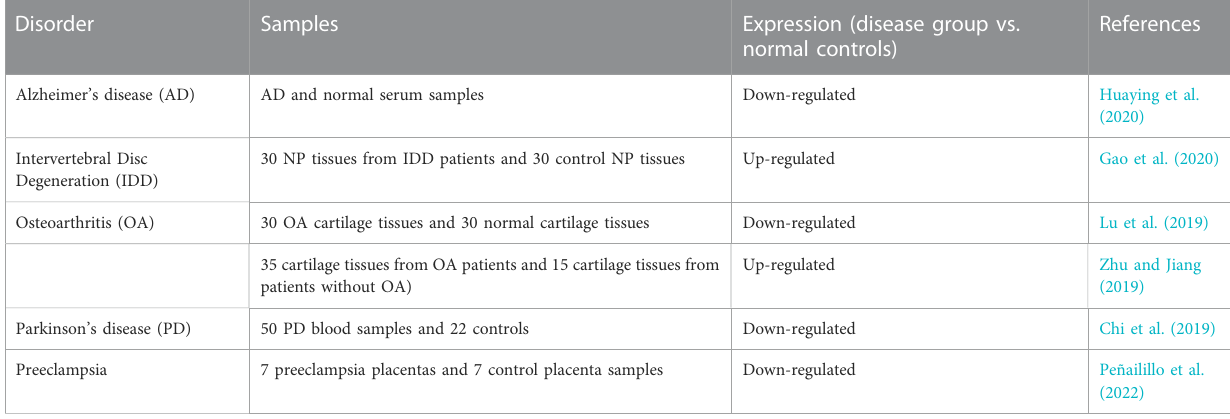
TABLE 10 Studies on humans samples to ascertain how PART1 is expressed in non-cancerous disorders (NP: nucleus pulposus).